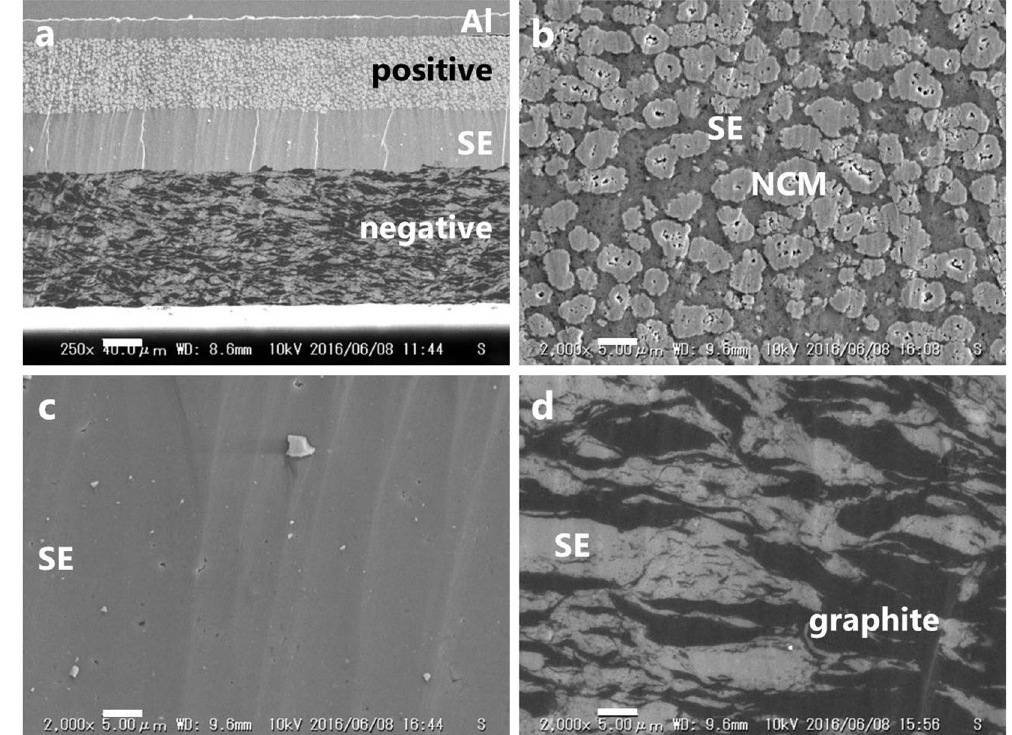
Figure 7. SEM images of intimate contact of SE and positive/negative layer maintained over 350 cycles. Cross- sectional SEM images of ( a ) the binder-free full-cell, (NCM:LS-LPS:AB:PPC = 80:20:2:3)/(LPS:PPC = 100:3)/ (graphite:LS-LPS:AB:PPC = 58:42:2:3), and the magnified images of the ( b ) positive layer, ( c ) SE layer and ( d ) negative layer after 350 cycles. Scale bar, ( a ) 40 μ m, ( b – d ) 5 μ